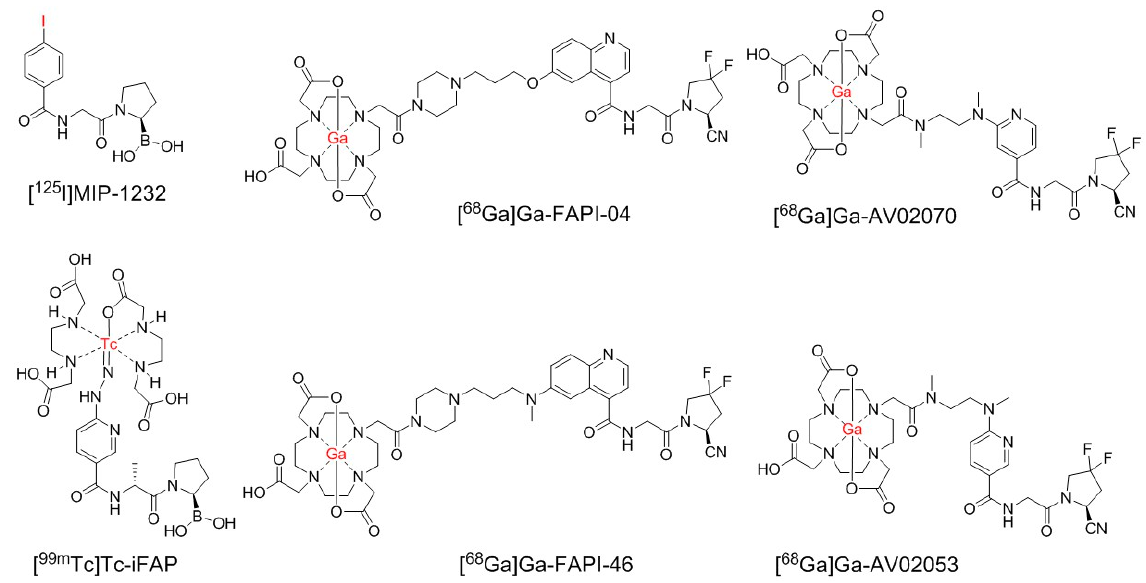
Figure 1. Chemical structures of 68 Ga-labeled AV02053 and AV02070, and previously reported [ 125 I]MIP-1232, [ 99m Tc]Tc-iFAP, and 68 Ga-labeled FAPI-04 and FAPI-46. The radiolabels are in red.